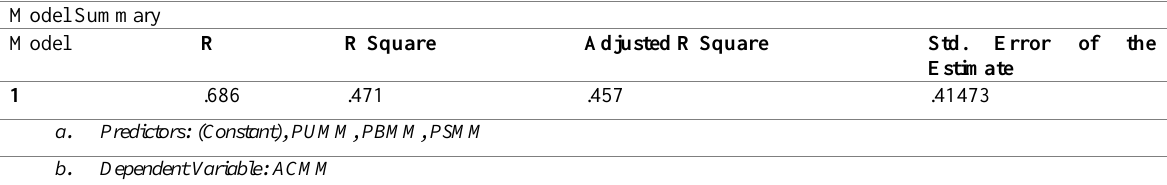
Table 7: Model Summary